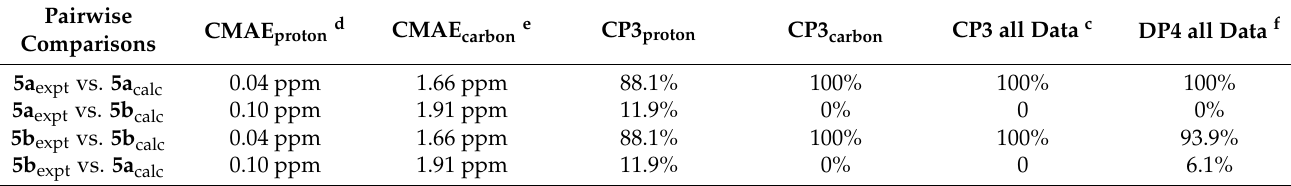
Table 4. Methods used for comparing the experimental and calculated chemical shifts data a,b .